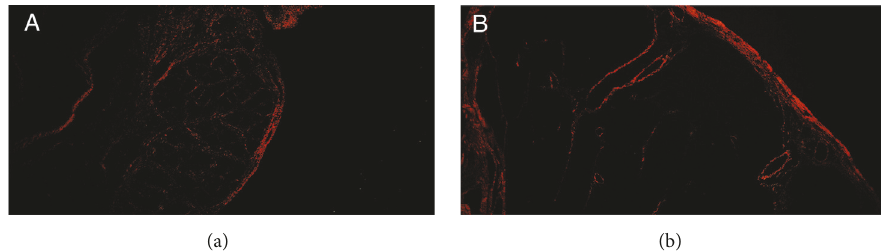
Figure 3: Analysis of collagen distribution. (a) The photomicrograph shows predominance of red in the testis of a control group fetus with 23 WPC, suggesting collagen type I presence. Picrosirius red with polarization × 20. (b) The photomicrograph shows predominance of red in prune belly fetal gubernaculum, suggesting collagen type I presence in a fetus with 31 WPC. Picrosirius red with polarization ×